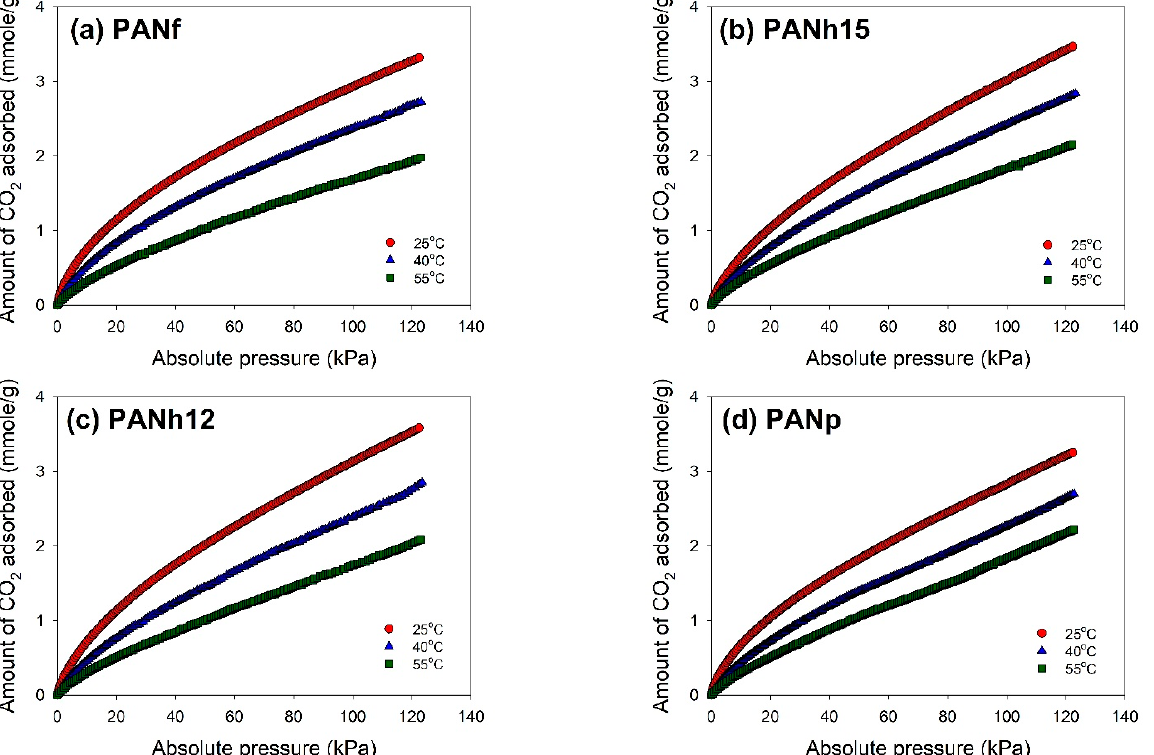
Figure 7. Adsorption isotherms of CO 2 of the ACNFs: ( a ) PANf; ( b ) PANh15; ( c ) PANh12; ( d ) PANp. The Q st values changing with the CO 2 loading (0.2 to 1.2 mmol/g) are shown